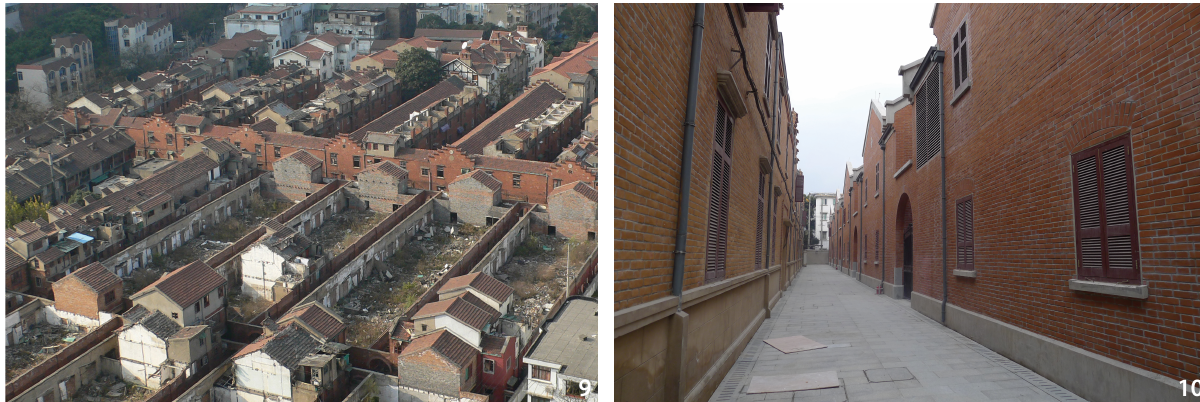
Figure 9 Jianye-li after partial demolition (Source: Institute of Shanghai Architectural Design and Research Co., Ltd). Figure 10 Jianye-li after reconstruction (Source: Institute of Shanghai Architectural Design and Research Co.,